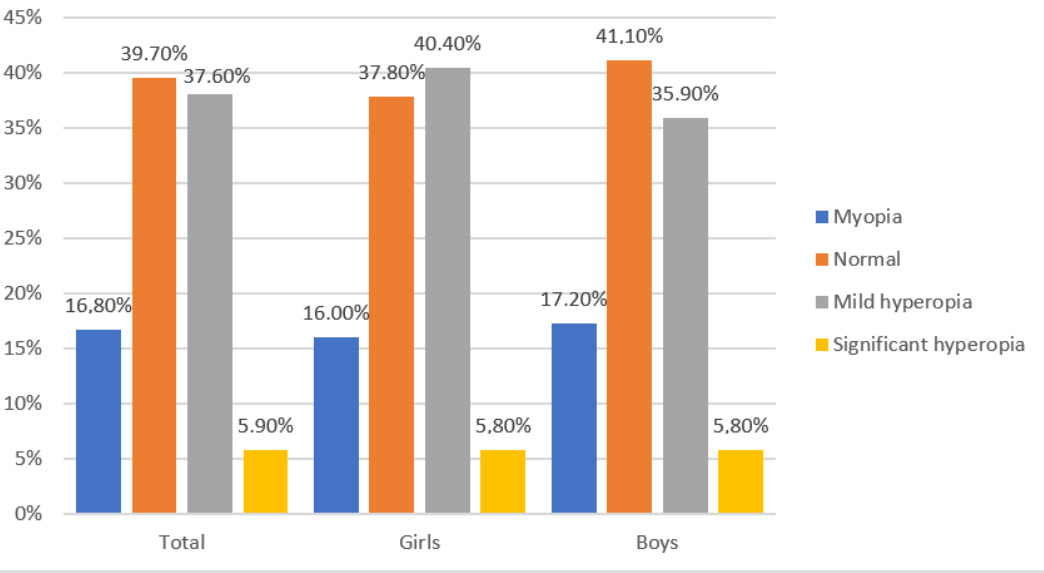
Figure 2. Prevalence of refractive errors after cycloplegia in the study group according to gender.